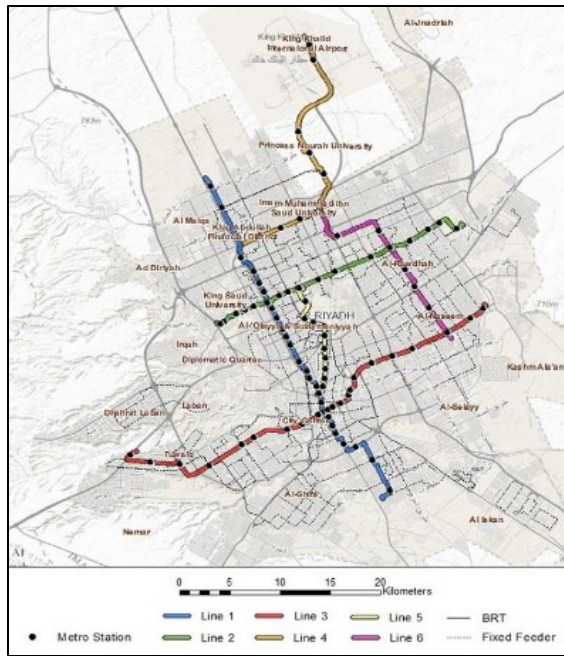
Figure 6. The planned public transport system in Riyadh - Metro Line (ADA, 2015).